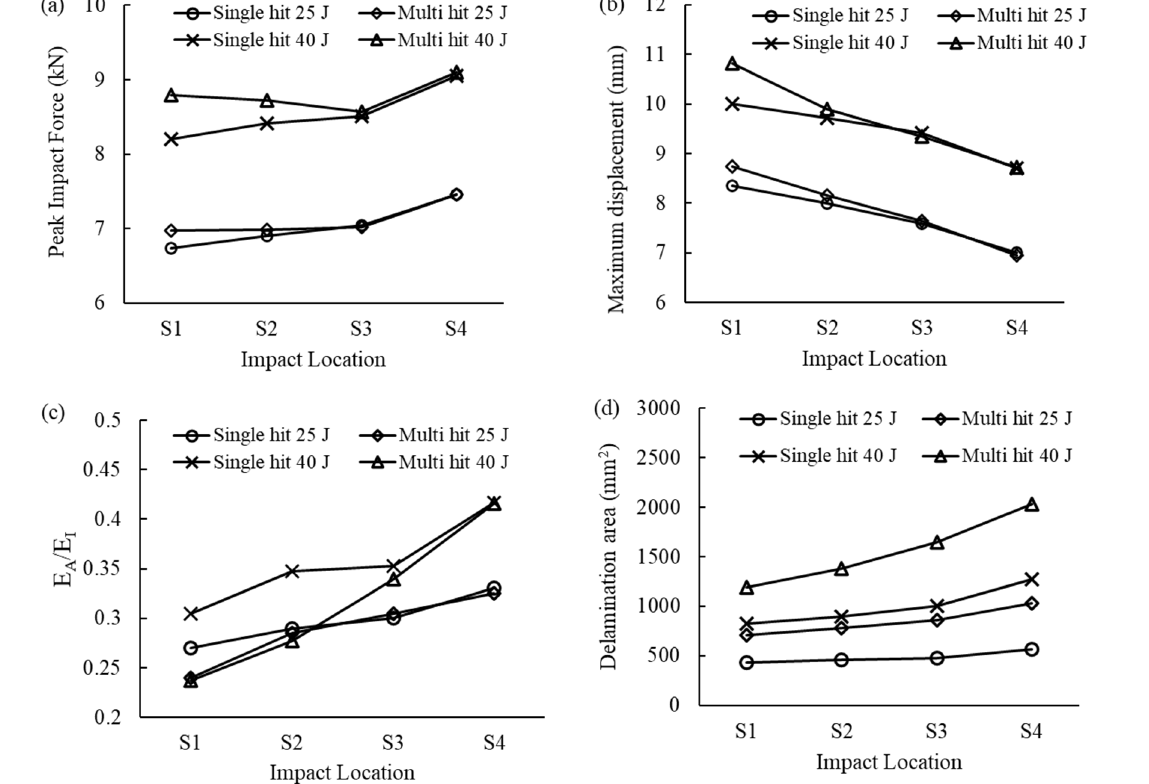
Figure 10. Comparison impact response for pristine panel and panel with pre ‐ existing damage: ( a ) Peak impact force, ( b ) Maximum displacement, ( c ) Ratio of absorbed energy to impact energy, and ( d ) Sum of projected delamination